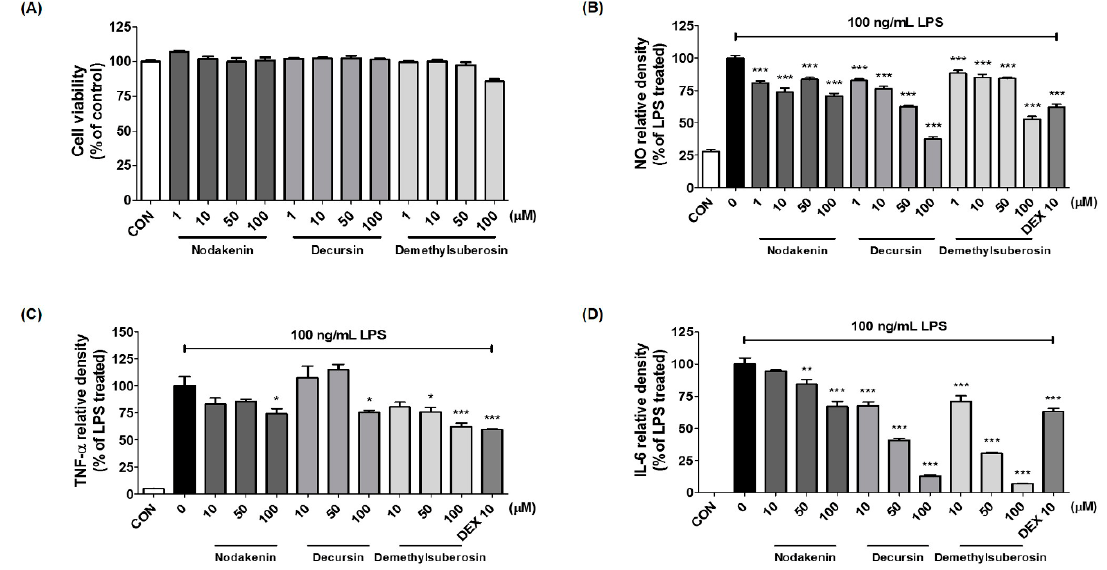
Figure 6. Effects of three compounds nodakenin, decursin, and demethylsuberosin on ( A ) cell viability and the secretion of ( B ) NO, ( C ) TNF- α , and ( D ) IL-6 cytokines. Data represent the mean ± SEM of duplicate determinations from three independent experiments. * p < 0.05, ** p < 0.001, and *** p < 0.0001 were calculated from comparisons with LPS stimulation values.